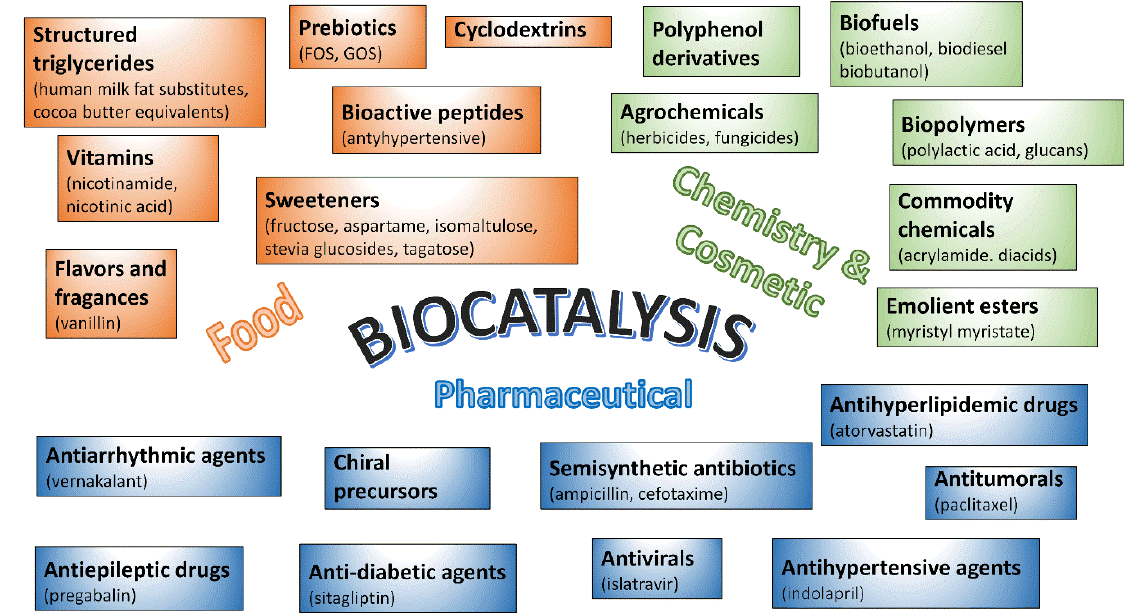
Figure 1. Examples of current applications of biocatalysis for the synthesis of compounds for the food, chemical, cosmetic and pharmaceutical industries. FOS: fructooligosaccharides; and GOS: galactooligosaccharides.